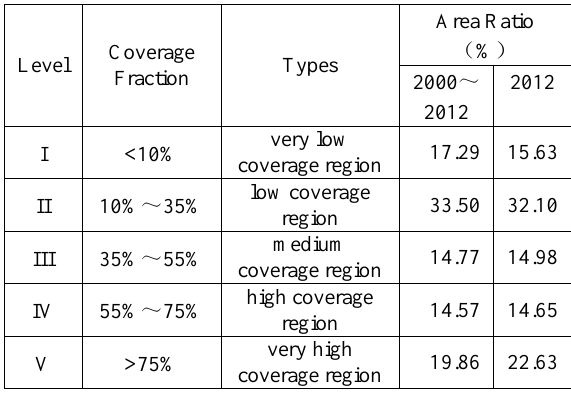
Table 2. The grade standard of vegetation coverage in Qinghai